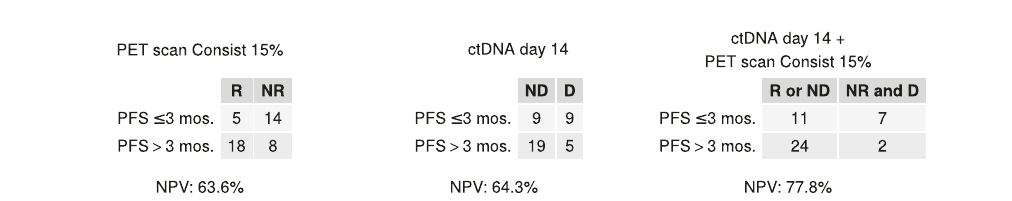
Fig. 2 Negative predictive value (NPV) of 18F-FDG-PET/CT metabolic non-response and ctDNA detection on D14 to predict early disease progression, after only 3 months of treatment with exemestane-everolimus. NPV (expressed in %) is displayed below each panel. PFS progression-free survival, NPV negative predictive value; R = 18 F-FDG-PET/CT responder; NR = 18 F-FDG-PET/CT non-responder; ctDNA = circulating tumor DNA; D-ctDNA detected; ND-ctDNA not detected; D14 = 14 days after starting treatment with